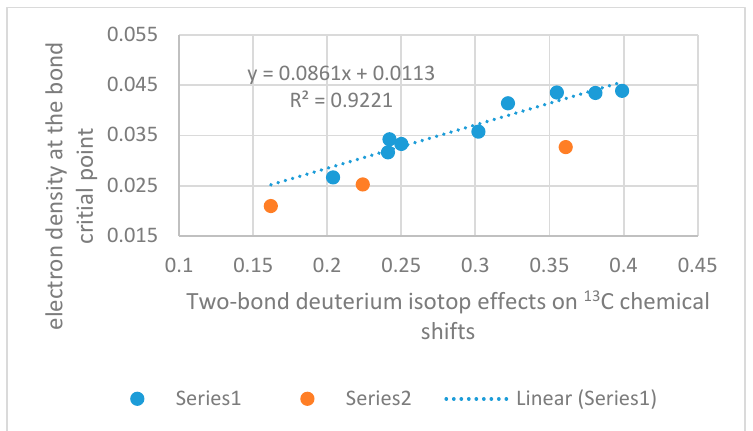
Figure 25. Plot of electron densities at the bond critical point vs. two ‐ bond deuterium isotope effects on 13 C chemical shifts in ppm. Series 1 include linear compounds with ketones and nitro groups as acceptors, Series 2 include cyclic compounds both 5 ‐ and 6 ‐ membered rings, ketones and esters. Isotope effects in ppm from [76,89,102,103]. The ring critical points were calculated using the B3LYP/6 ‐ 311++G(d,p) functional and the AIM program.